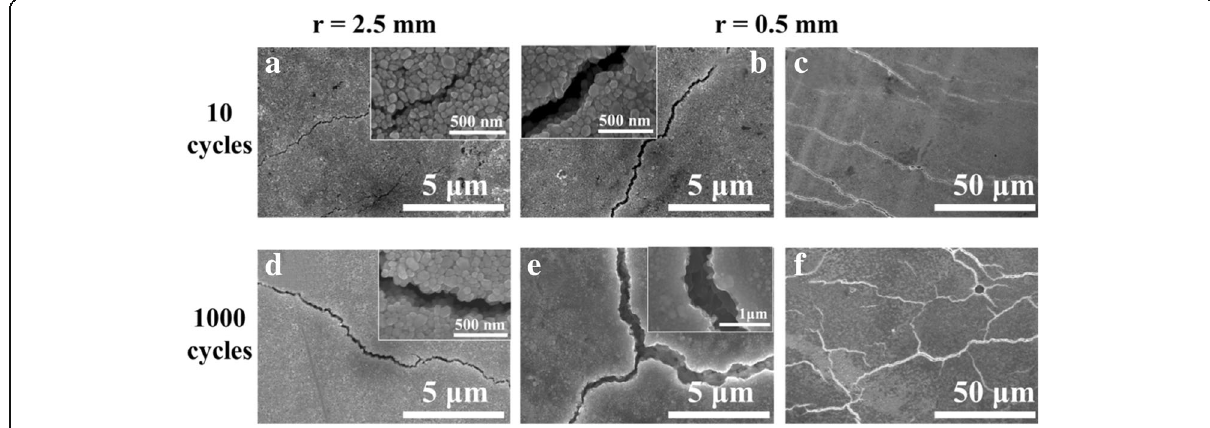
Fig. 8 SEM images of the silver electrodes on art coated paper in various bending test conditions. a Bending radii of 2.5 mm in 10 cycles. b , c Bending radii of 0.5mm in 10cycles with different magnifications. d Bending radii of 2.5mm in 1000cycles. e , f Bending radii of 0.5mm in 1000 cycles with different